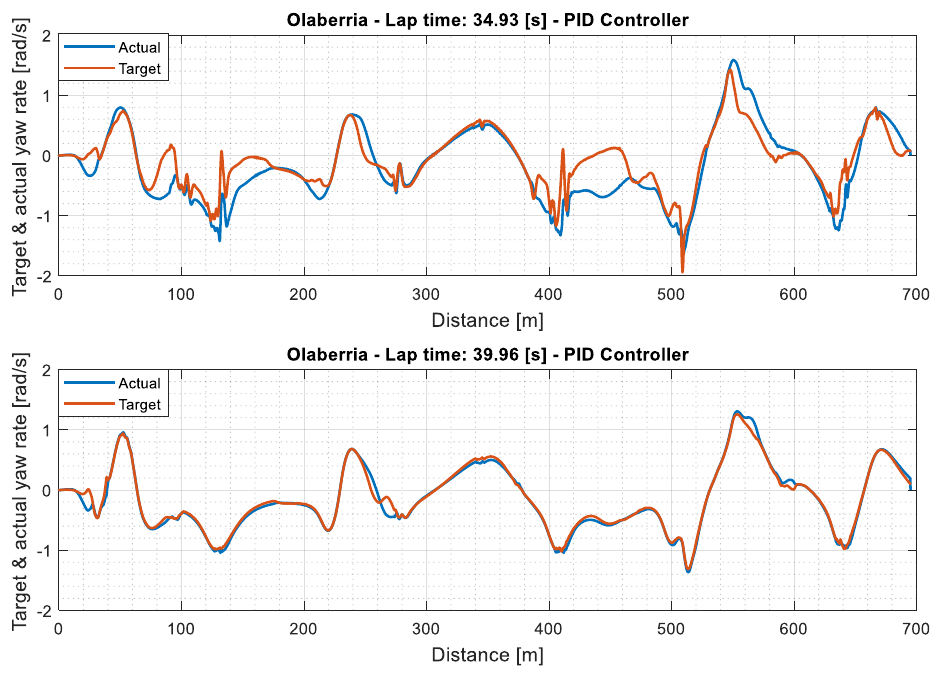
Figure 10. Target vs. actual yaw rate in a “fast” and a “slow” lap.